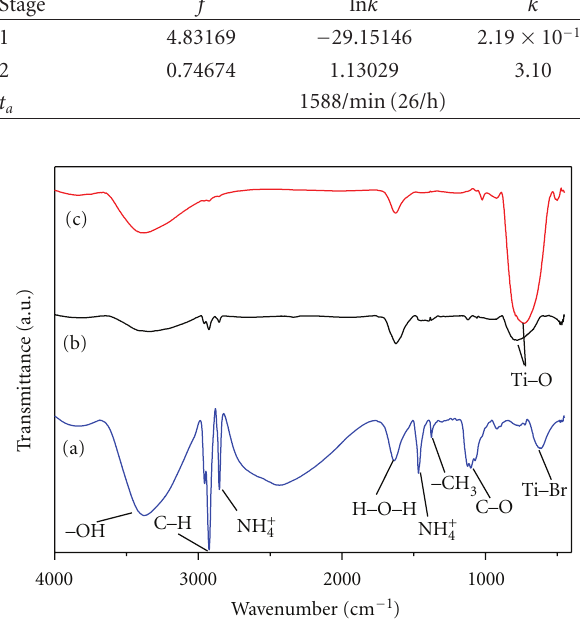
Figure 7: FT-IR spectra of (a) TiO 2 precursor, (b) TiO 2